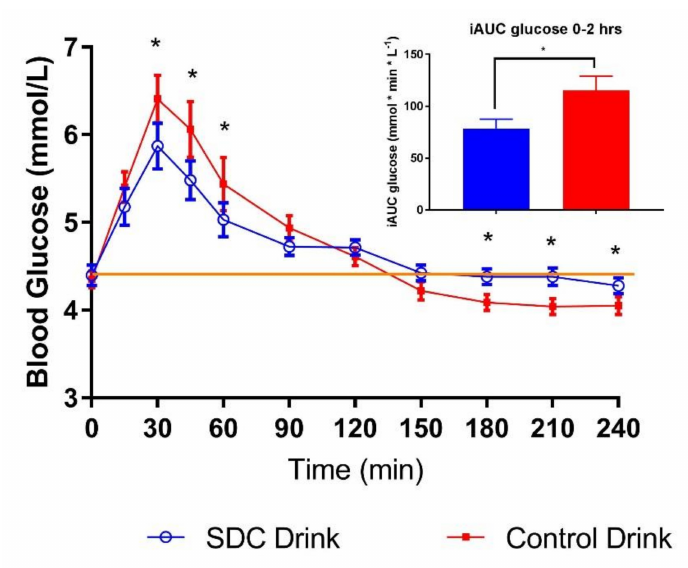
Figure 2. Post-prandial glycemic response of drink-mixes (SDC and Control) in healthy adults. Data are mean ± standard error mean (SEM); Yellow line indicates baseline value * indicates treatments were significantly di ff erent at specific time points in the paired t -test ( p <